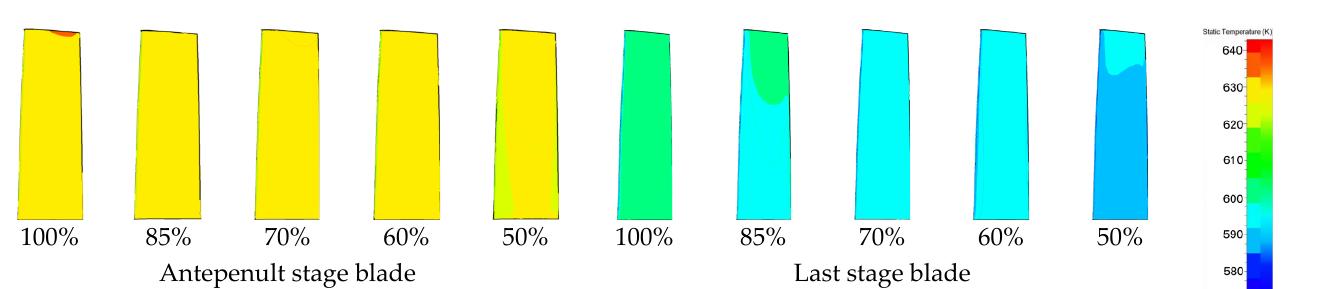
Figure 16. Static temperature distribution on M-P surfaces with different back pressures (70% load ratio).